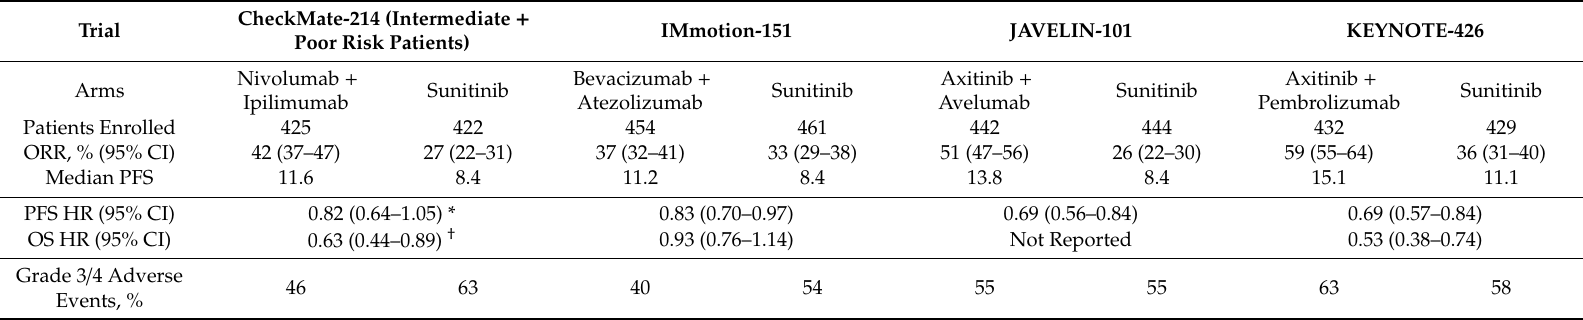
Table 1. Results from four phase-III clinical trials investigating front-line immune checkpoint inhibitor use in metastatic renal cell